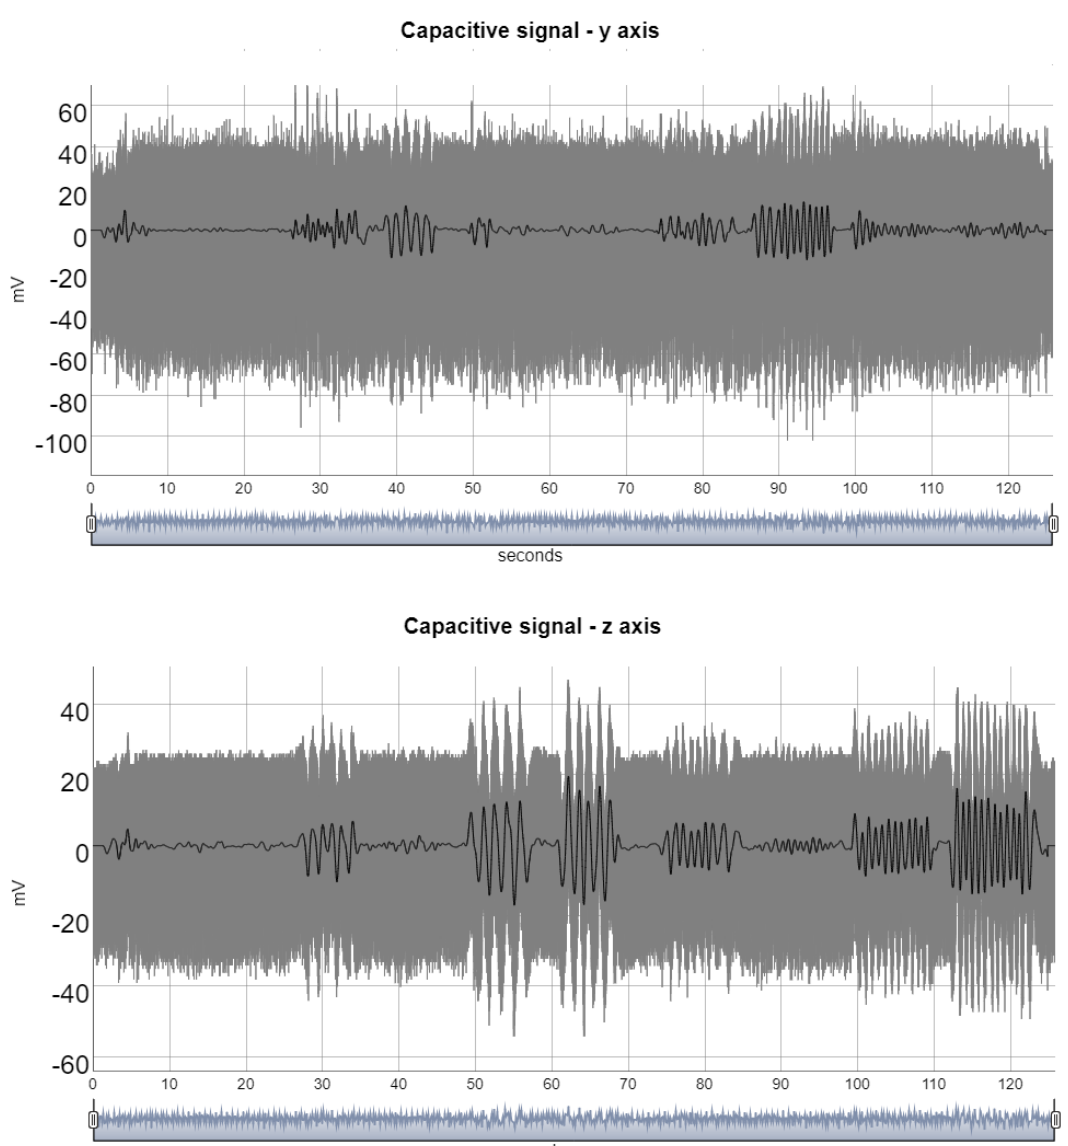
Figure 5. The graphics show the capacitive signal on the y and z − axis. The original signal is plotted in gray and the filtered signal, representing the voluntary movement, is plotted in